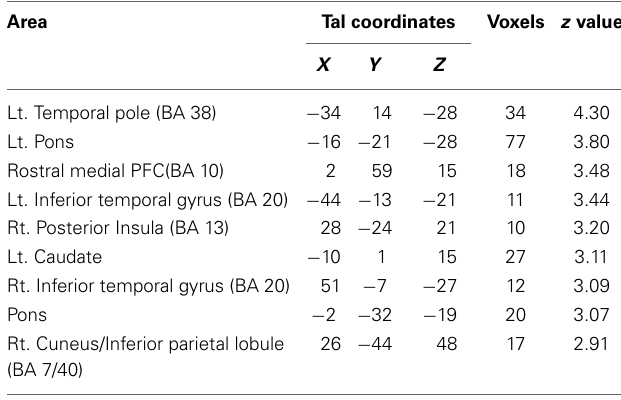
Table 5 | Areas activated by the main effect of interpersonal emotion regulation (interpersonal emotion regulation - watch > intrapersonal emotion regulation >